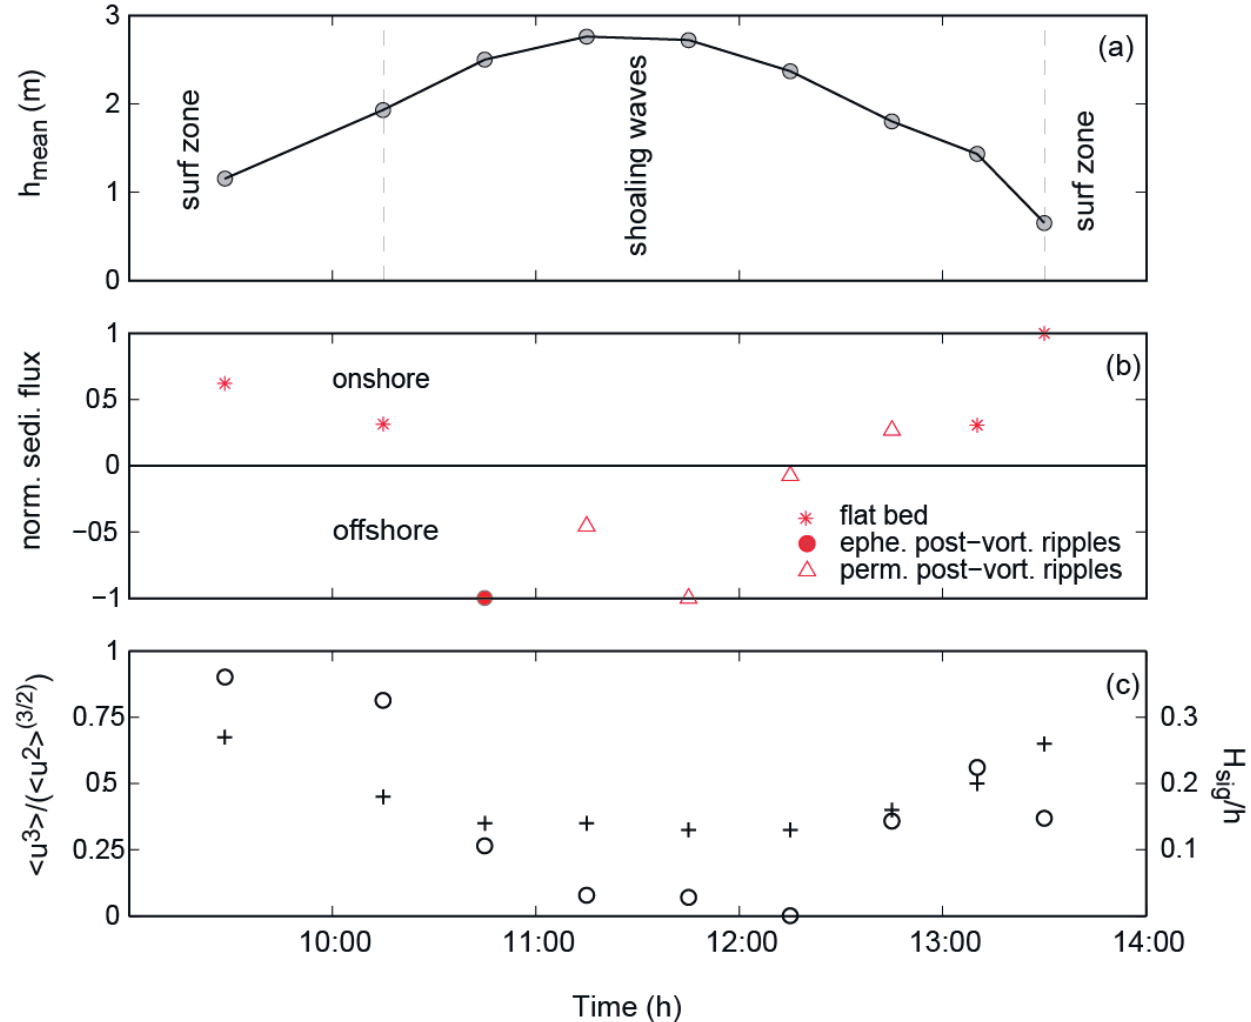
Figure 9. Variation of ( a ) the mean water depth; ( b ) the normalised net cross-shore suspended sediment flux due to swell waves (ephe. post-vort: ephemeral post vortex; perm. post-vort: permanent post vortex); ( c ) the normalised velocity skewness (o) and the ratio